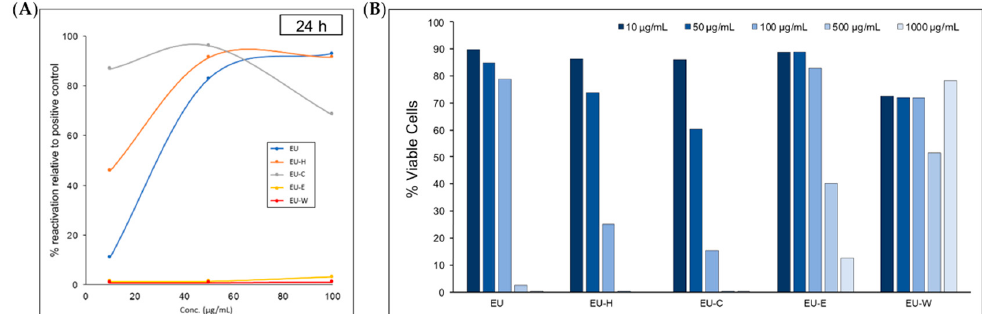
Figure 1. HIV-1 latency reversal activity of methanolic crude extract (EU), partitioned n -hexane (EU-H), dichloromethane (EU-C), ethyl acetate (EU-E), and water-soluble residue (EU-W) phases. ( A ) dose-response experiments conducted with Jurkat T cells that were latently infected with full-length HIV-1 reporter construct (J-Lat 10.6 cells), HIV-1 reactivation quantified as % of positive control (PMA); ( B ) cell viability of each sample at 10, 50, 100, 500, and 1000 μ g/mL.